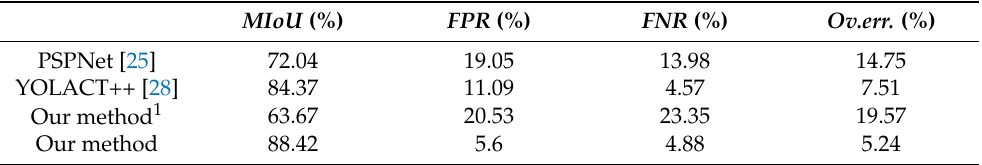
Table 1. Comparison of segmentation performance of three methods.